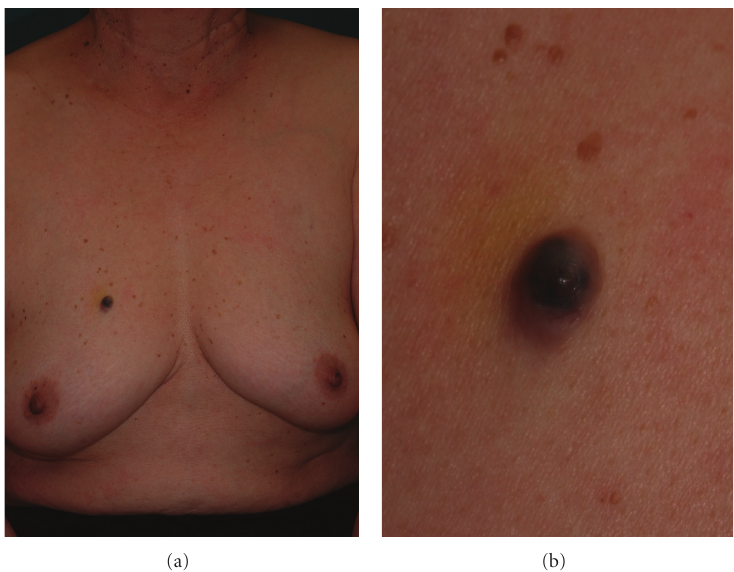
Figure 1: (a) A well-demarcated blue/black nodule was recognized on the right anterior chest. (b) high maginification.